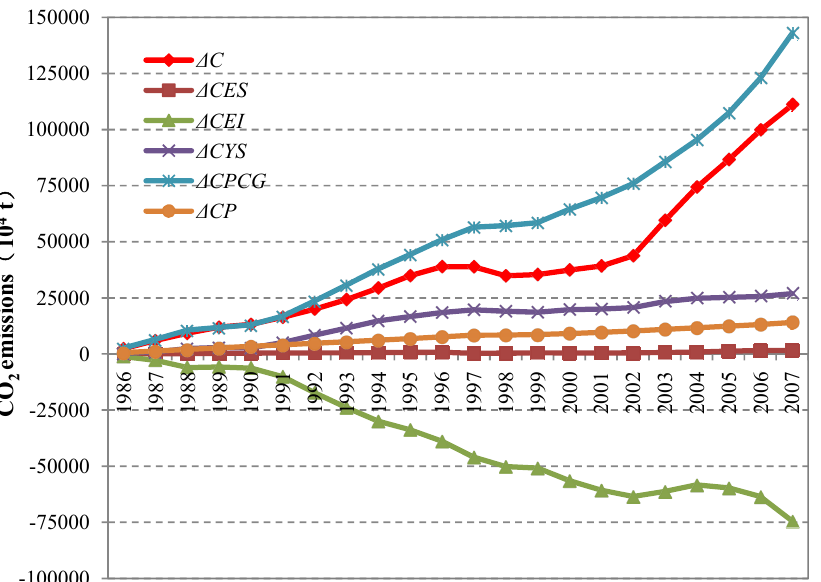
Figure 4. Cumulative contribution values of influencing factors of the energy-related industrial CO emissions. 2